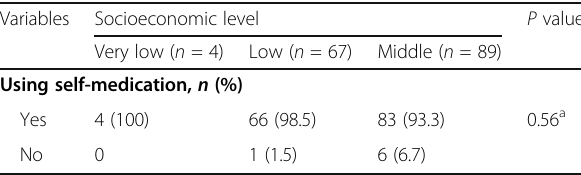
Table 2 Association between socioeconomic level and using